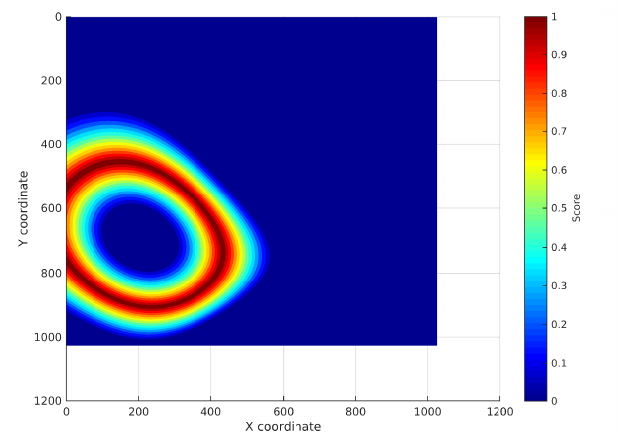
Figure 3. Localization subsurface for an AP: possible coordinates having a certain RSS collected at an unknown coordinate.